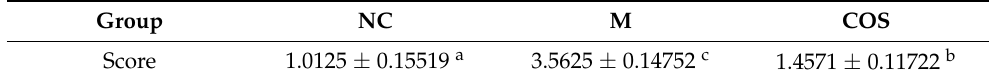
Table 1. The mitochondrial scores of mice. Group